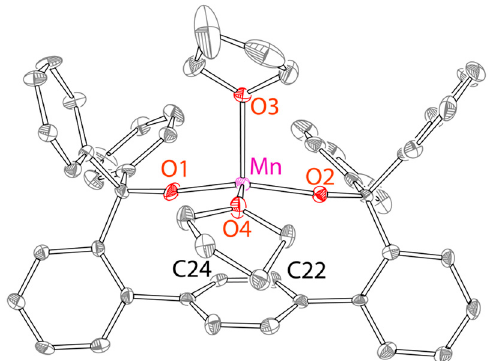
Figure 1. X-ray structure (50% probability) of Mn[O-terphenyl-O] Ph (THF) 2 ( 2 ). Alternative conformations of one of the top THF ligands and one of the lateral phenyls, H atoms, and disordered solvent were omitted for clarity. Selected bond distances (Å) and angles ( ◦ ): Mn-O1 1.888(5), Mn-O2 1.922(4), Mn-O3 2.205(4), Mn-O4 2.178(4), O1-Mn-O2 150.3(2), and O3-Mn-O4 91.23(2).